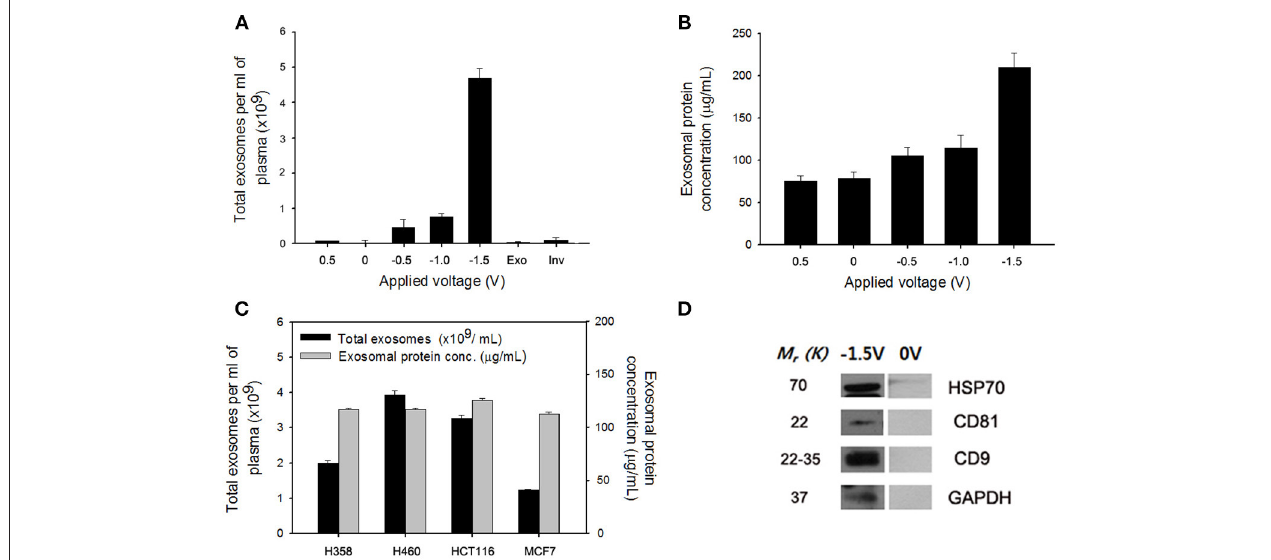
FIGURE 3 | (A) Electric field-mediated controlled isolation of exosomes from the culture medium of MDA-MB-231 breast cancer cells using the nanowires (NWs) platform in response to various electrical potentials. (B) Quantification of the exosomal proteins isolated from the NW platform at various potentials. (C) Verification of the exosome yield and exosomal proteins level from four different cancer cell lines (i.e., NCI-H358 and NCI-H460 lung cancer cells, MCF7 breast cancer cells, and HCT116 colon cancer cells) upon application of − 1.5V. (D) Western blotting of exosomes released at − 1.5V to evaluate the expression level of exosomal proteins isolated from the culture medium of MCF7 cells. Data are shown as the mean ± standard deviation ( n = 5).